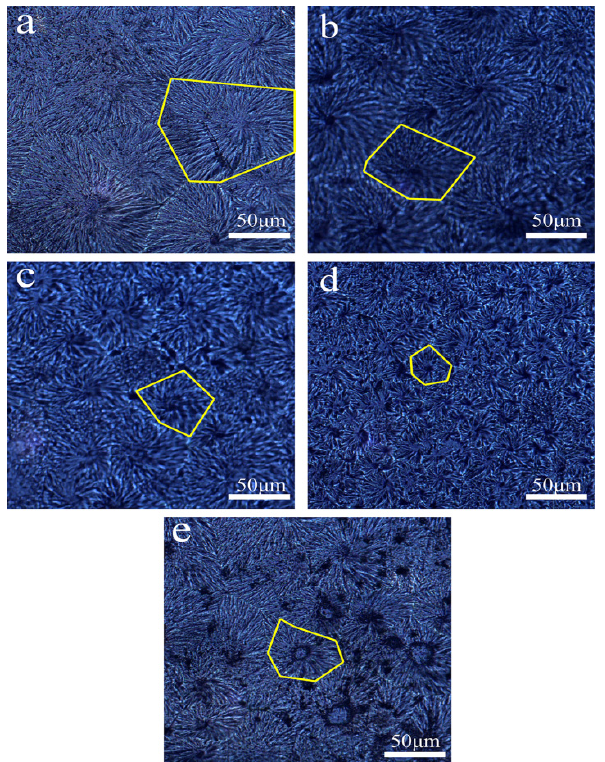
Figure 13. Polarized optical microscopy photographs of POM/Ag nanocomposites with different Ag nanoparticle contents: ( a ) 0, ( b ) 0.1, ( c ) 0.5, ( d ) 1, ( e ) 2 wt % (The yellow parts indicate spherulites).